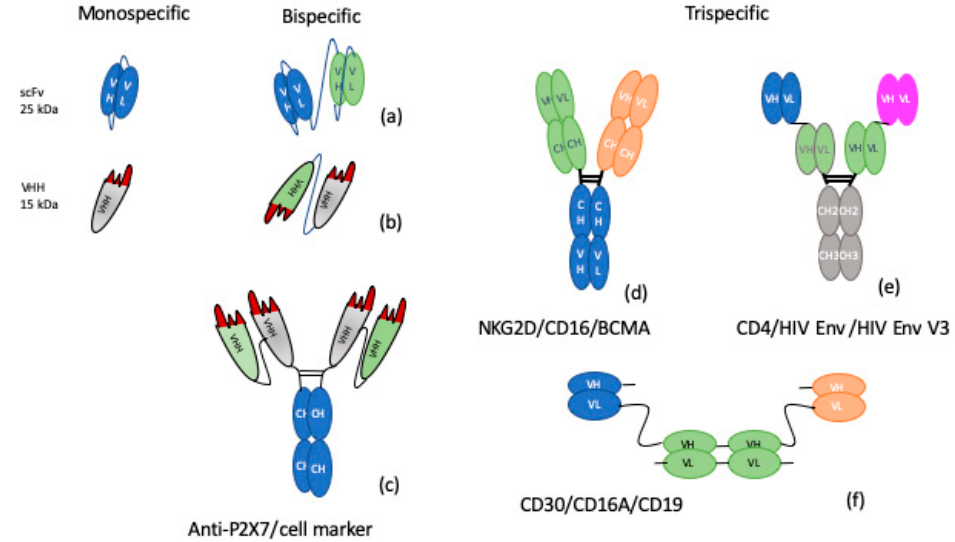
Figure 1. Alternative formats for bispecific or trispecific antibodies. From left to right: Monospecific, VH, VL, and VHH, (nanobody); Bispecific, antibodies, such as scDiabody ( a ), Diabody ( b ), and tandem VHH, on Fc ( c ). Trispecific, formats are represented as combinations of three VH/VH domains fused via six CH domains ( d ), three different VH/VL domains fused to Fc ( e ), and three VH/VL domains with linkers ( f ). VL, VH, and VHH domains are shown in blue, green, gray, and orange according to their respective antigen specificity. Peptide linkers are shown as thin black lines. with VH = variable domain of the heavy chain; VL = variable domain of the light chain; VHH = variable heavy Homodimer, CH = constant domain of heavy chain.